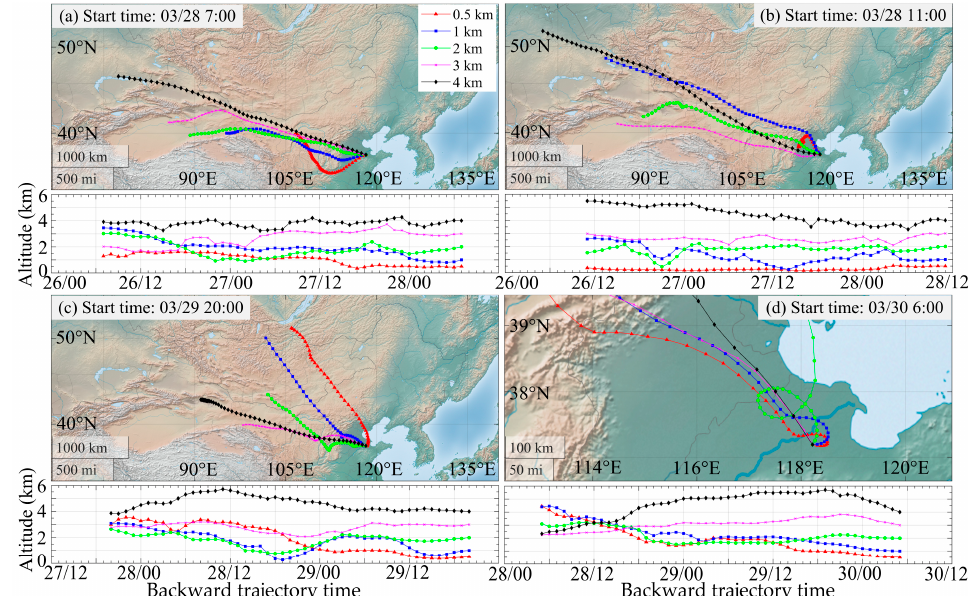
Figure 6. The 48 h HYSPLIT backward trajectory result calculated at ( a ) 7:00 on 28 March, ( b ) 11:00 on 28 March, ( c ) 20:00 on 29 March, and ( d ) 6:00 on 30 March. The starting location is set as 0.5 km, 1 km, 2 km, 3 km, and 4 km over the lidar sites.